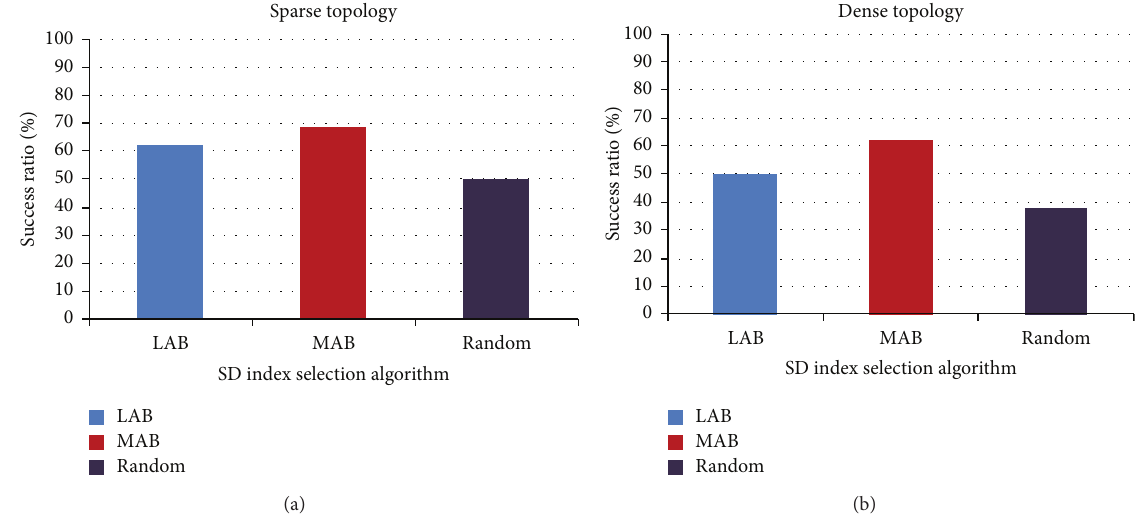
Figure 8: Experiment results of the distributed permission method.